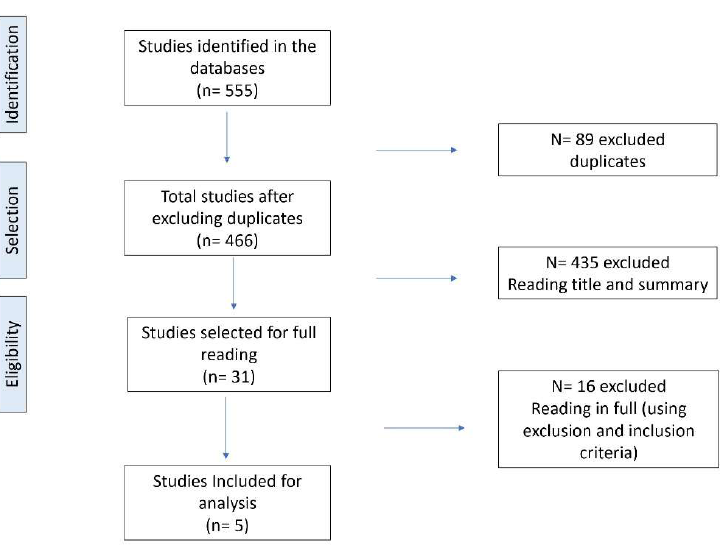
Figure 1. Flow diagram of the number of studies selected and included in the meta-analysis.